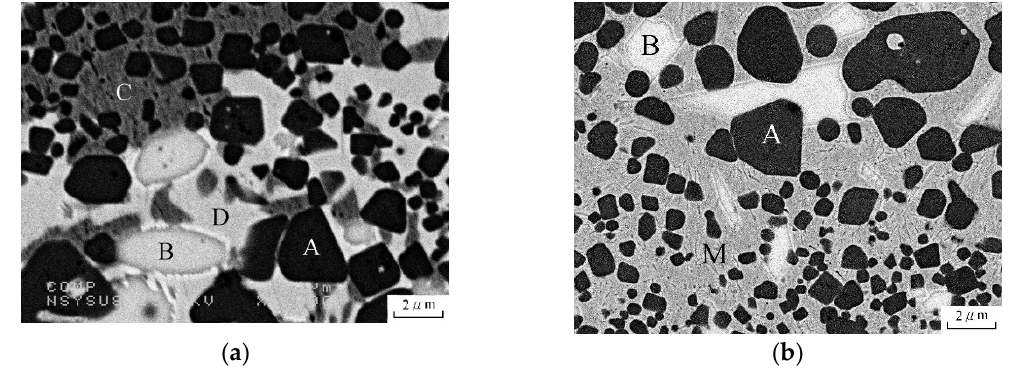
Figure 1. Microstructures of the Cu-23 at. %Ti–17 at. %Sn alloy under ( a ) furnace-cooled and ( b ) water-quenched.